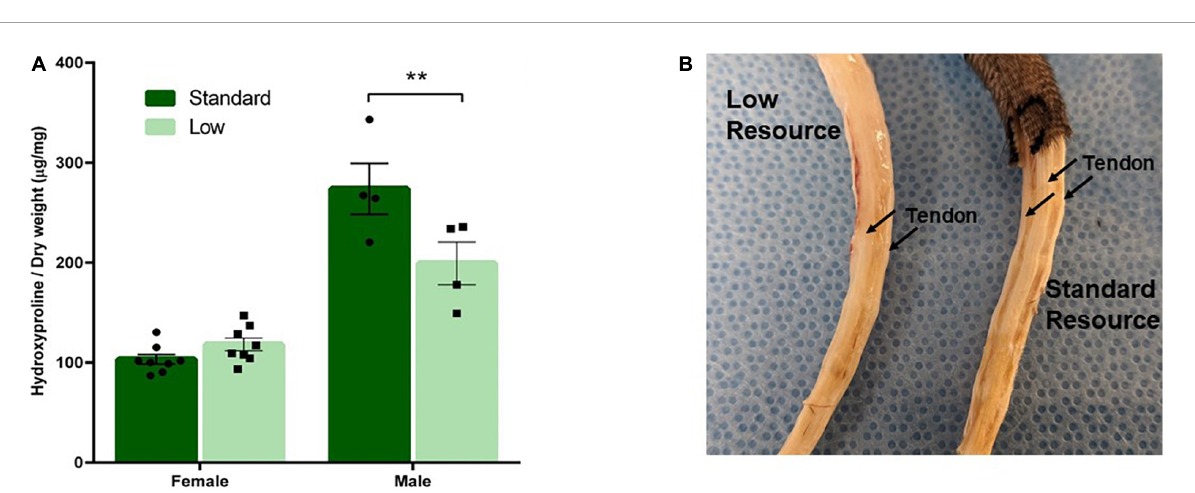
FIGURE9 Tendon characterization. One tendon from each tail was removed after PND 56 and analyzed for collagen content. (A) Tendon collagen concentration represented by amount of hydroxyproline normalized to dry weight of the tendon and (B) representative picture of male low and standard resource tails once skin was removed. Females had no difference in tail tendon collagen concentration between resources at PND 56. Standard resource males had significantly higher collagen concentrations (** p = 0.002) compared to low resource males at PND 56, suggesting more developed tendons. This was also observed in visible assessment with standard resource tails having well defined, larger tendons in comparison to low resource males. Individual data points overlay bars showing means ± SEM ( n = 8 for SR Females, SR Males, and LR females; n = 6 for LR